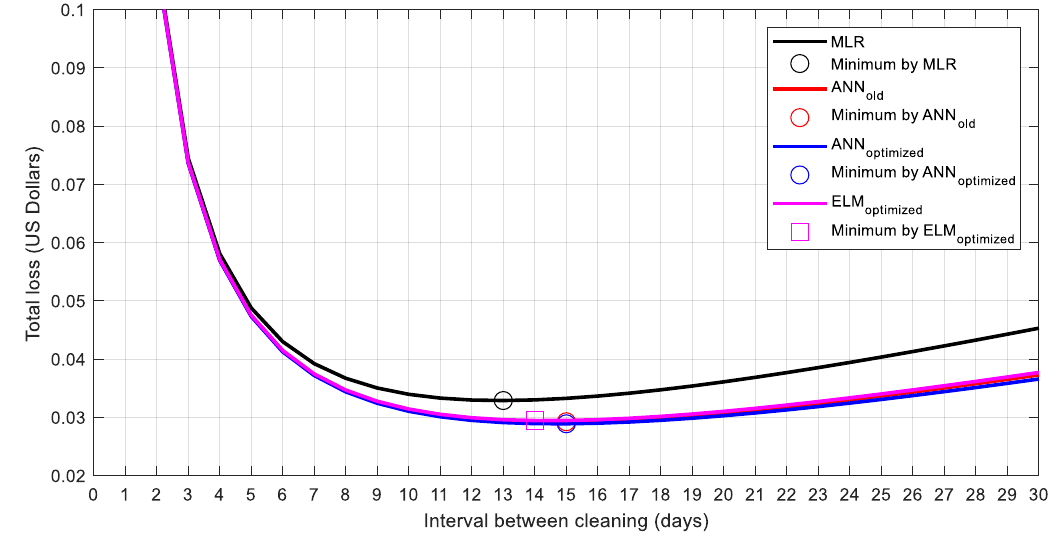
Figure 9. Total average daily losses due to cleaning cost and dust accumulation.